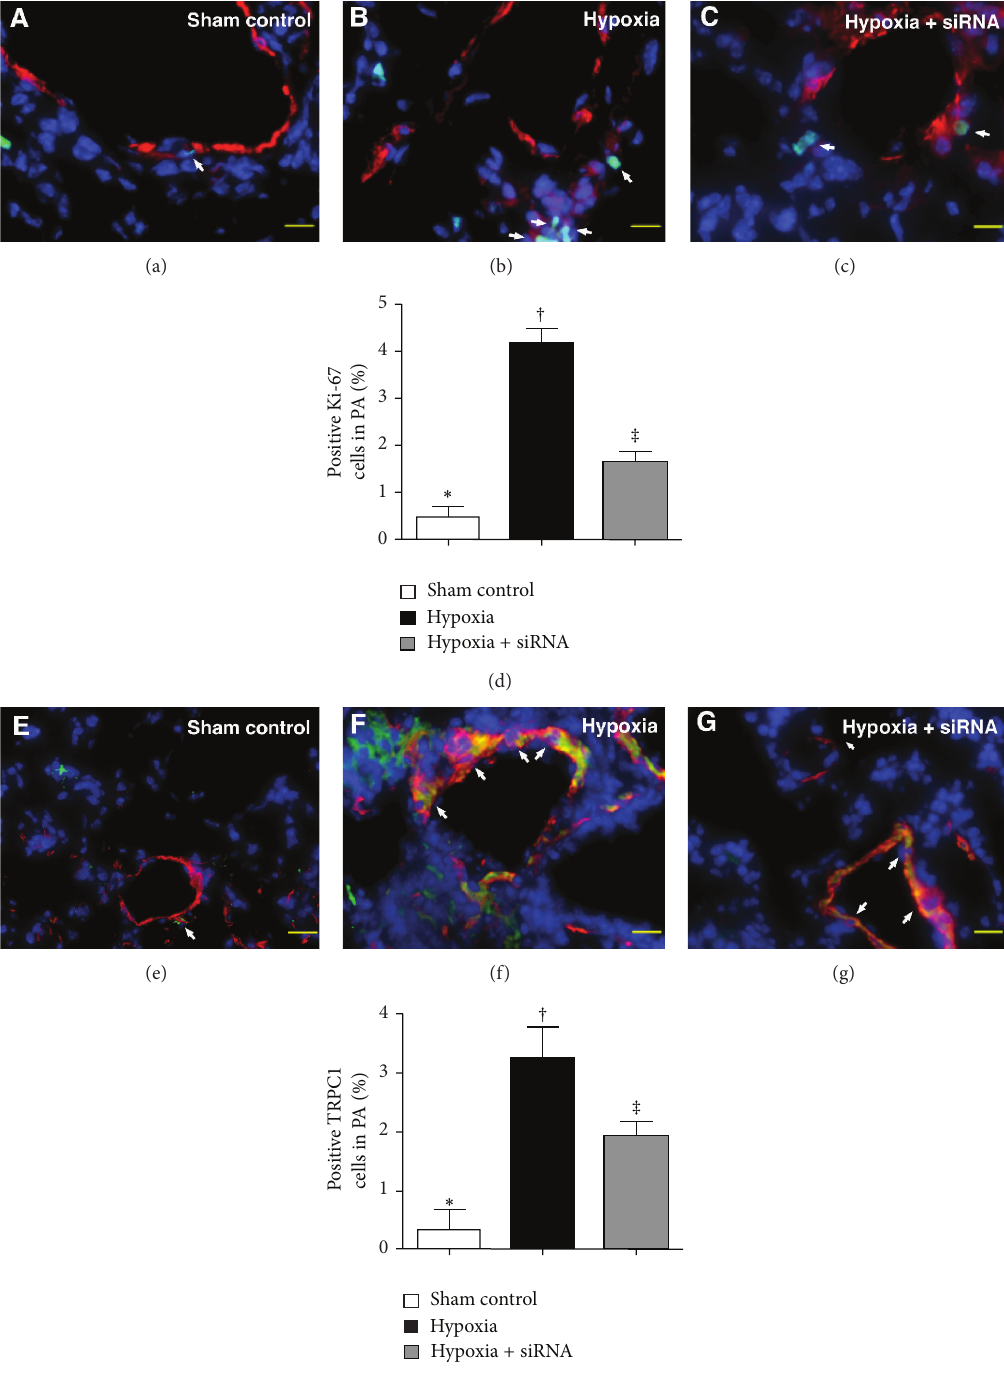
Figure 4: Immunofluorescent (IF) staining for Ki-67+ cells and TRPC1+ cells in medial layer of large pulmonary arterioles (PA) by day 28 after pulmonary arterial hypertension (PAH) ( 𝑛 = 10 ). ((a) to (c)) Identification of Ki-67+ cells in PA (white arrow) with IF double staining (i.e., 𝛼 -SMA-Ki-67) in three groups of animals (400x). (d) ∗ versus other groups with different symbols ( ∗ , † , ‡ ), 𝑃 < 0.0001 . ((e) to (g)) Identification of TRPC1+ cells in PA (white arrow) using IF double staining (i.e., 𝛼 -SMA- 𝛾 -TRPC1) in the three groups (400x). (h) ∗ versus other groups with different symbols ( ∗ , † , ‡ ), 𝑃 < 0.0001 . The scale bars in right lower corner represent 20 𝜇 m. Blue fluorescence indicates DAPI-stained nuclei. Statistical analysis in (d) and (h) using one-way ANOVA, followed by Bonferroni multiple comparison post hoc test. Symbols ( ∗ , † , ‡ ) indicate significance (at 0.05